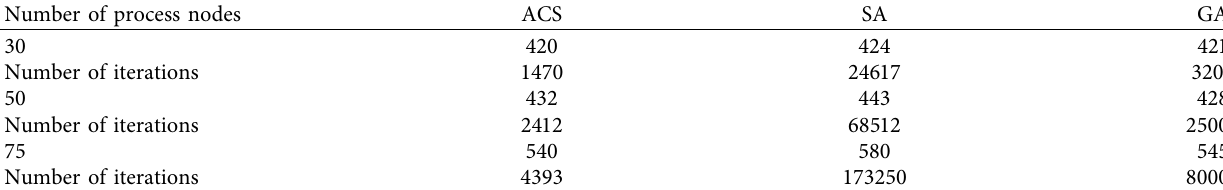
Table 3: Convergence speed comparison results.